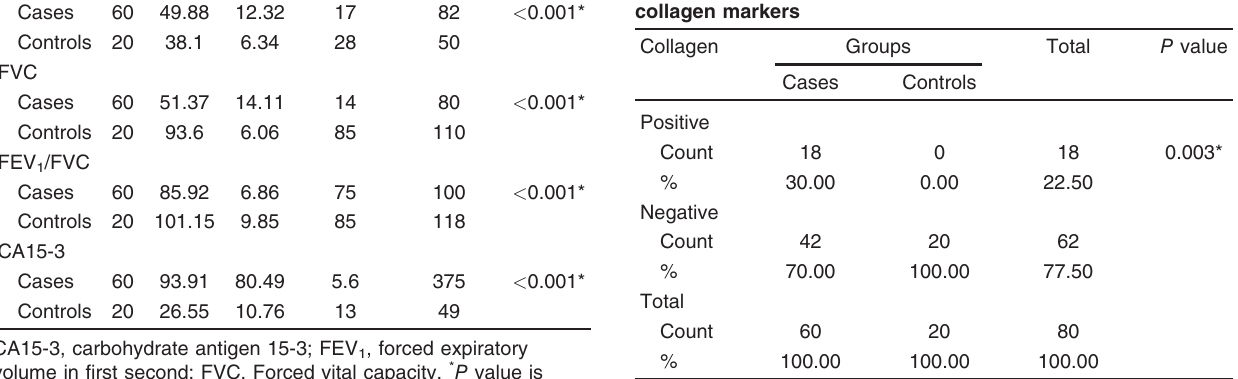
Table 3 Association between computed tomography findings and forced vital capacity in the three groups FVC N Mean SD Ground